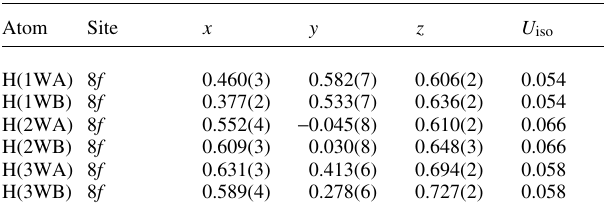
Table 2. Atomic coordinates and displacement parameters (in Å 2 )